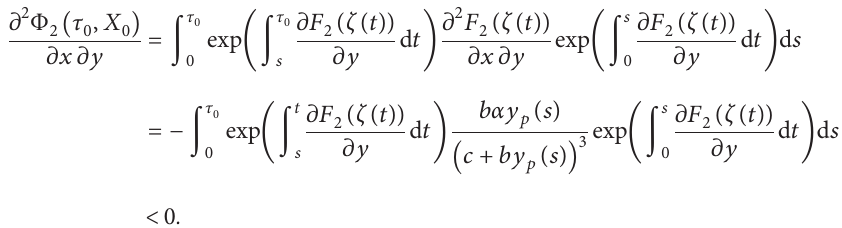
� 9 . 4. The other parameter values identical to those in Figure 3. The initial 1 ,y ) � ( 1 . 4 , 2 . 1 ) ; ( C − D )( x ,y ) � ( 1 . 8 , 2 . 6 ) 0 0 0 0